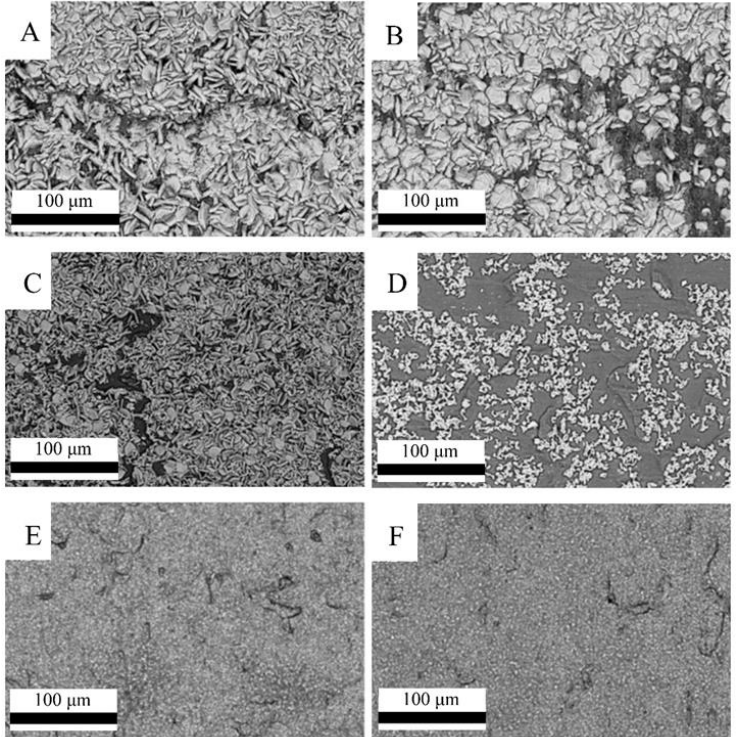
Figure 4. The back-scattered SEM images of phosphate coatings: AL1-N ( A ), AL1-NG ( B ), AL2-N ( C ),